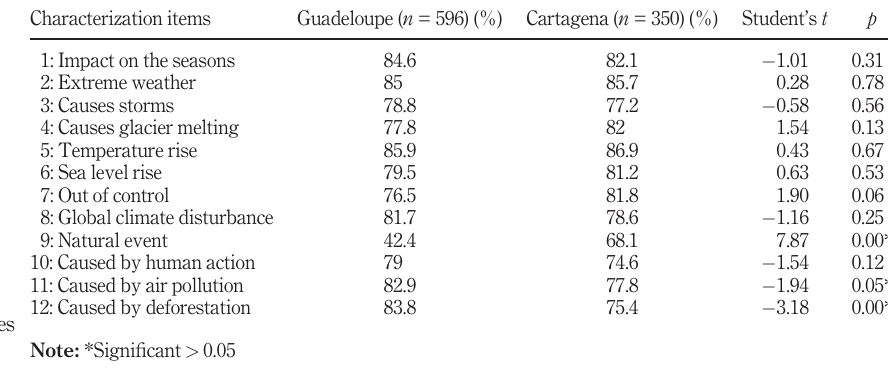
Table 3. Comparisons of the characterization rates of the